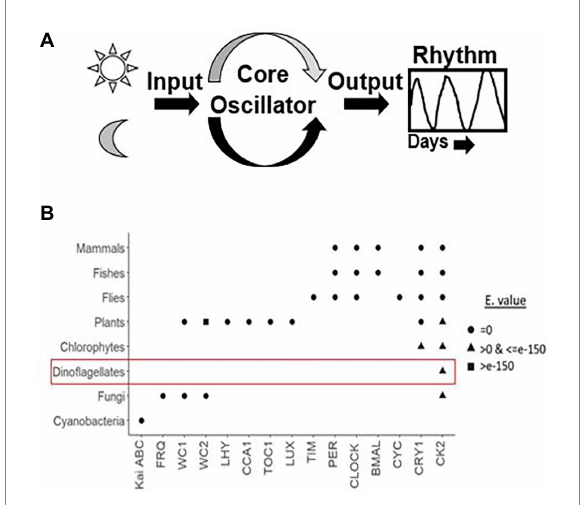
FIGURE 1 (A) Generalized depiction of the internal clock organization. Apart from the core oscillator, that consist of the cogs and gear that oscillate independently without the requirement of any external cues, there are cellular factors that convey the external signal to the cell-based oscillator called Inputs and others that take the information from the oscillator and then generate the overt rhythms, called outputs. Inputs synchronize the endogenous clock to the environmental time, which makes the clock flexible to adjustments to different light regimes at different time zones. (B) Dot plot showing an overview of all known clock components across various taxa based using the R algorithm. X and Y-axes denotes core clock proteins and model organisms, respectively. The row corresponding to each organism constitute the clock proteins present in it. The shapes represent the respective e-values. We used three approaches, firstly, for clock model organisms we directly documented the evidence from the KEGG pathway database. Secondly, for organisms that are well annotated we got their clock genes from the literature. Thirdly, for dinoflagellates annotation is not yet comprehensive. Therefore, the clock proteins from respective species were downloaded from either the KEGG pathway “circadian rhythm” subsection or the NCBI database. Each clock protein was blasted (tblastn) against the dinoflagellate comprehensive datasets in NCBI with these parameters (Query coverage - ≥ 50%, Percent identity - ≥ 50% and E value <E-10). We accept only if all the 3 criteria are satisfied. The clock proteins found in dinoflagellates are encircled, note the presence of Casein kinase in all known